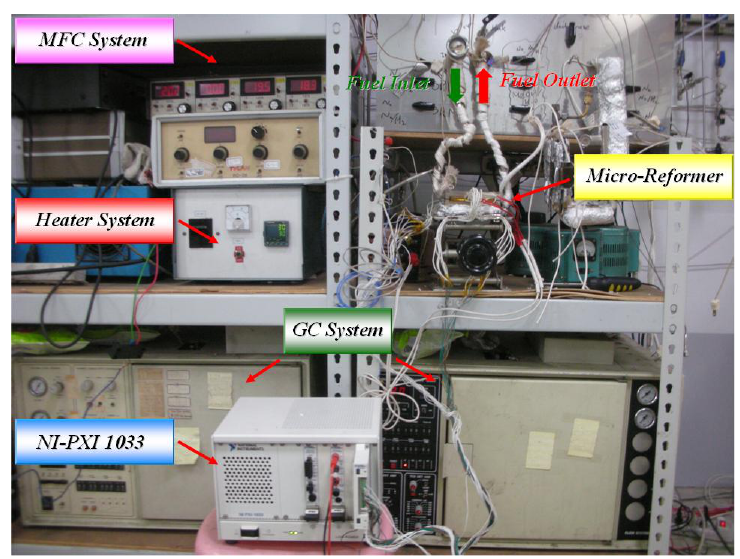
Figure 4. Calibration system.